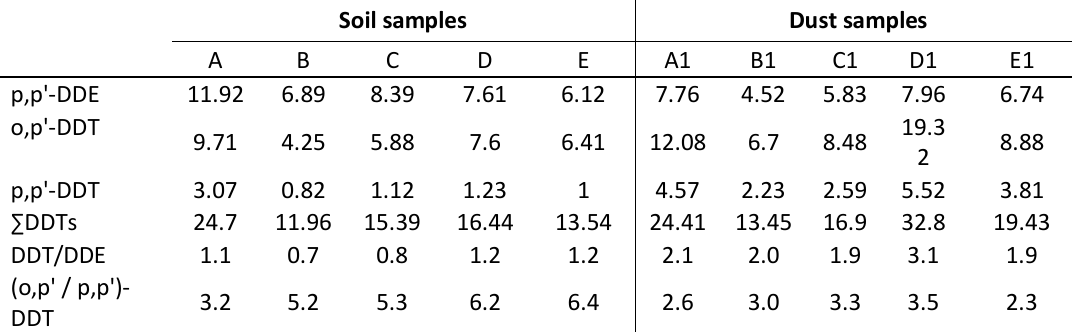
Table 2. Residue concentrations of DDTs in parks soil and dust from Ulaanbaatar city (ng·g -1 ) Soil samples